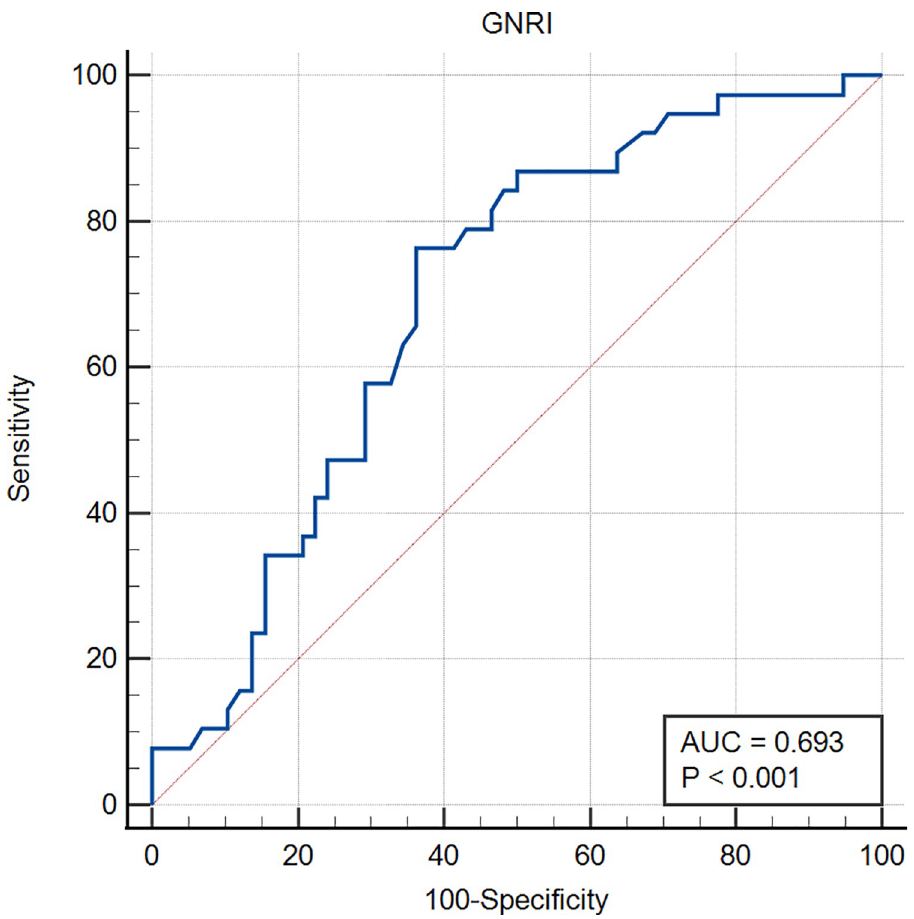
Fig 1. ROC curve of GNRI for prediction of postoperative